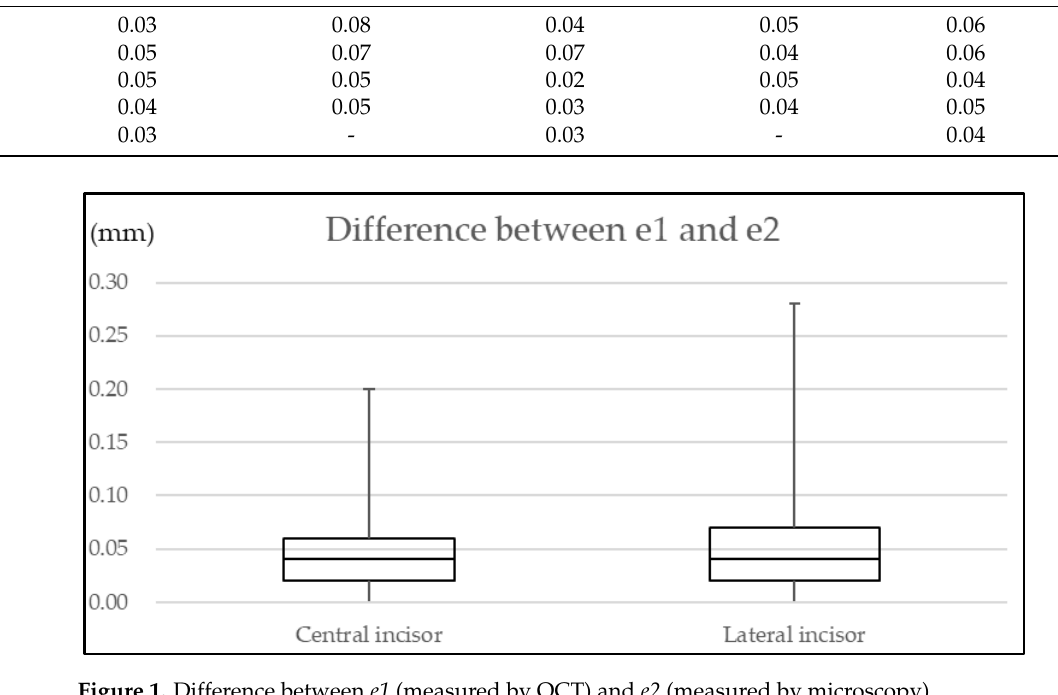
Table 2. Median of difference between e1 (measured by OCT) and e2 (measured by microscopy) for maxillary lateral incisors (mm) .